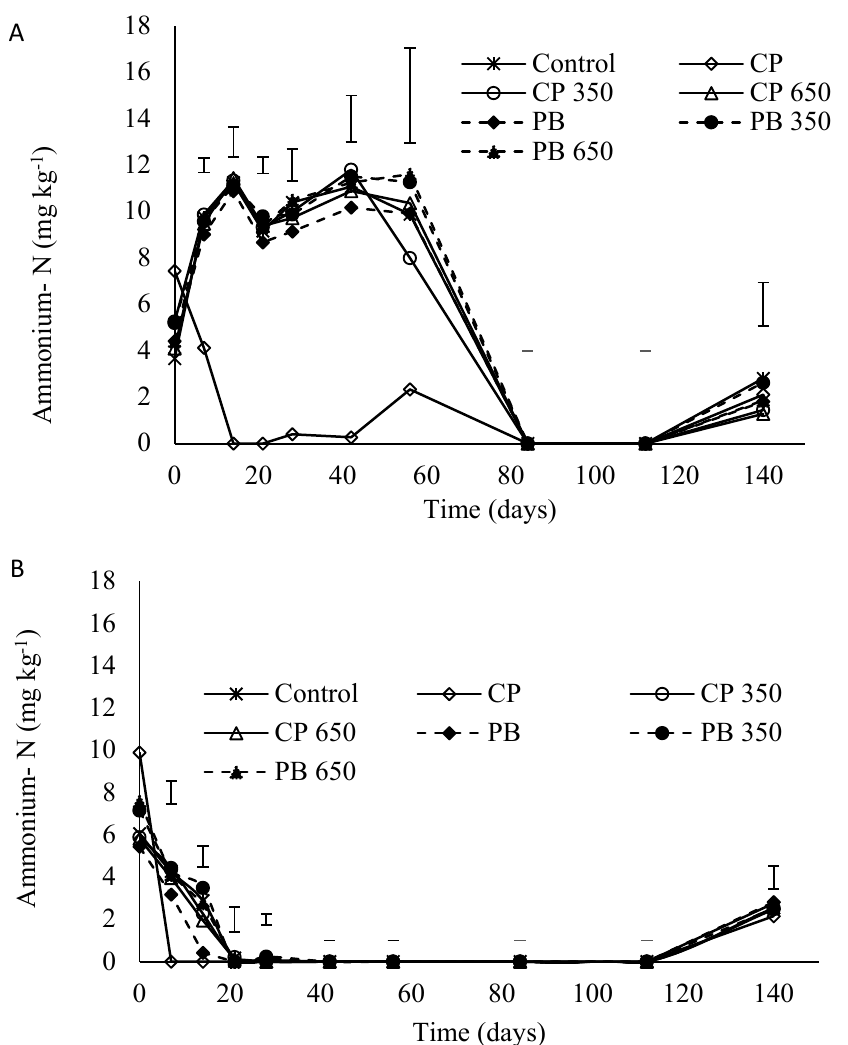
Figure 5. Concentrations of ammonium − N during incubation of Luvisol ( A ) and Ferralsol ( B ) amended with biochar from cull potato (CP) and pine bark (PB) produced at varying pyrolysis temperatures. CP = cull potato; PB = pine bark; CP 350 = cull potato biochar at 350 °C; CP 650 = cull potato biochar at 650 °C; PB 350 = pine bark biochar at 350 °C; PB 650 = pine bark biochar at 650 °C. The vertical error indicates LSD ( p < 0.05).